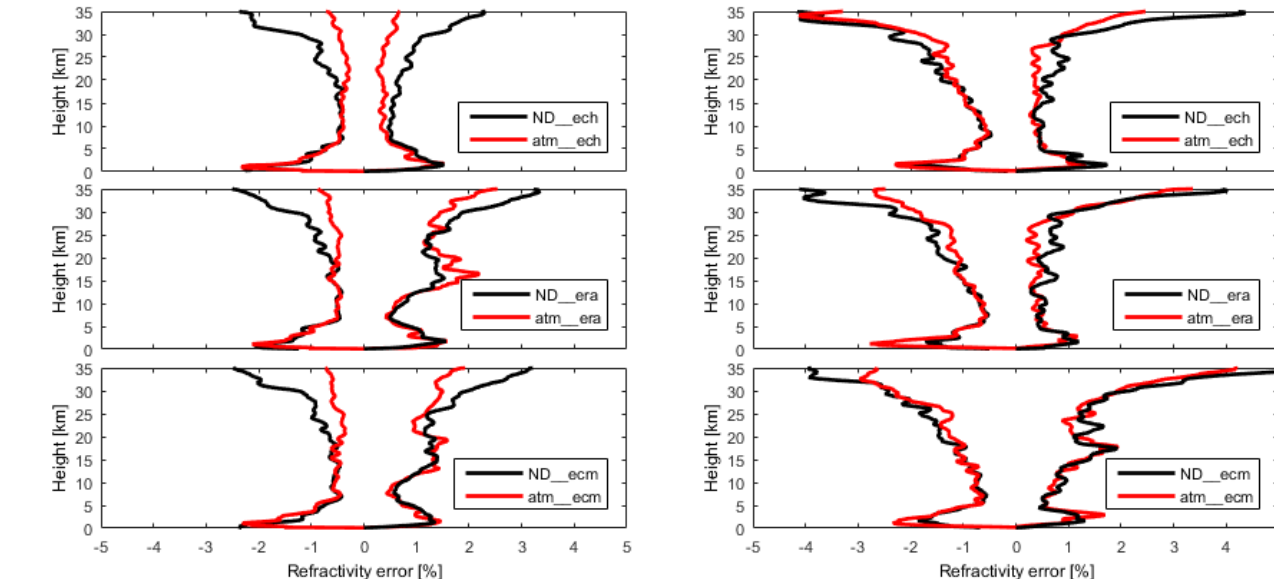
Figure 6. The mean relative refractivity deviation compared R_N and atmPrf with ECMWF analyses in setting RO events. ND_ech represents the average relative refractivity deviation between ND- derived and echPrf; atm_ech denotes the average relative refractiv- ity deviation between atmPrf and echPrf; ND_era shows the av- erage relative refractivity deviation between ND-derived and er- aPrf; atm_era expresses the average relative refractivity deviation between atmPrf and eraPrf; ND_ecm is the relative refractivity devi- ation between ND-derived and ecmPrf; atm_ecm signifies the aver- age relative refractivity deviation between atmPrf and ecmPrf; R_N is the relative refractivity derived from ND-derived AEP for the se- lected 200 RO events based on ROPP software.